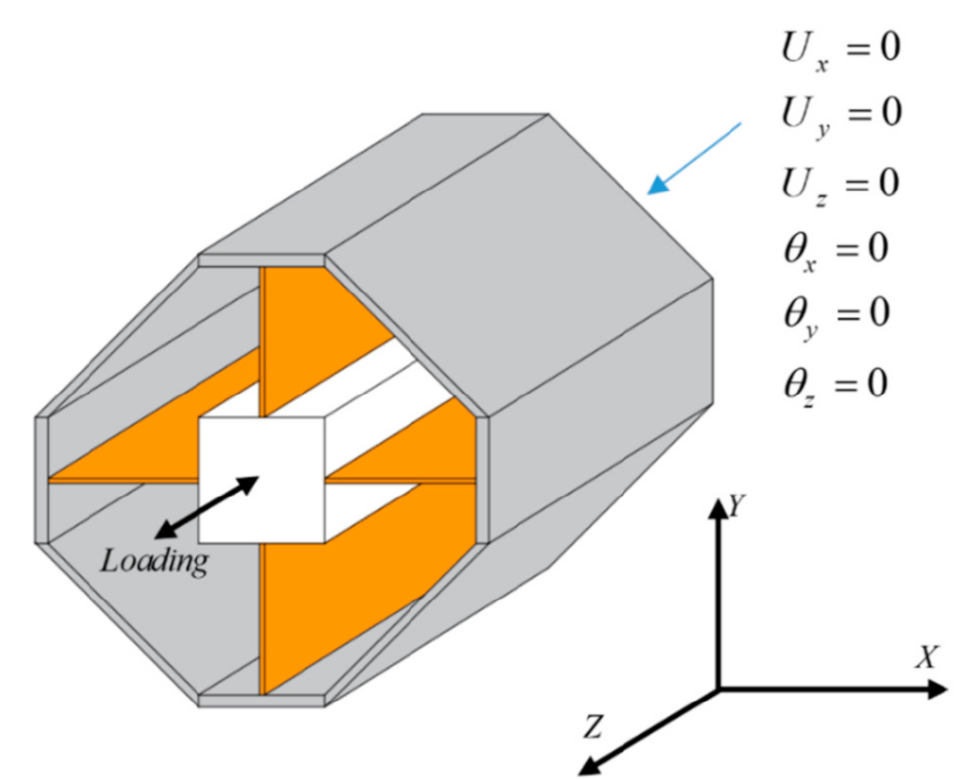
Figure 9. Loading direction and boundary conditions of the proposed damper.